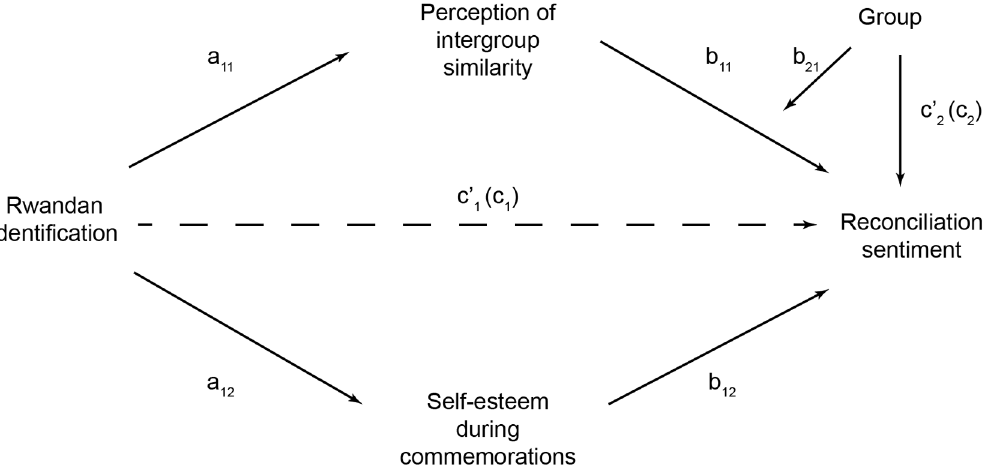
Figure 1. Moderated mediation analysis of the effect of Rwandan identification on reconciliation